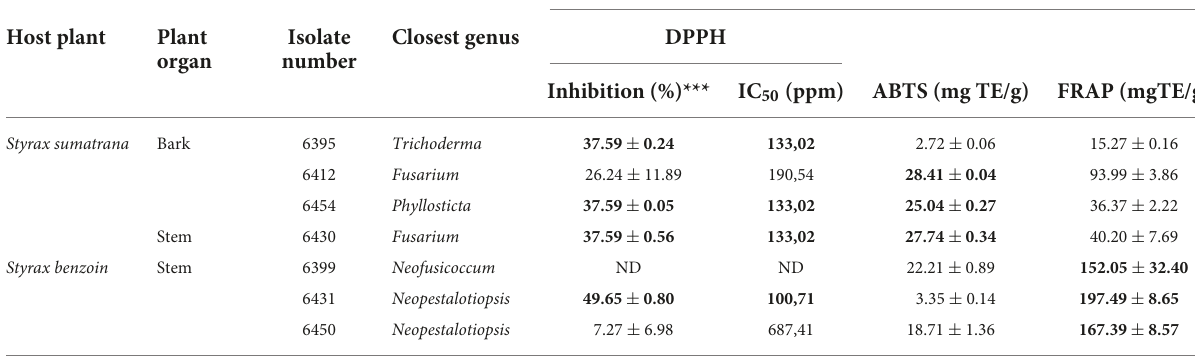
TABLE 2 Fungal isolates with high antioxidant activity determined by 2,2-diphenyl-1-picrylhydrazyl (DPPH), 2,2 (cid:48) -azino-bis (3-ethylbenzothiazoline-6-sulphonic acid) (ABTS), and ferric reducing antioxidant power (FRAP) assay*.